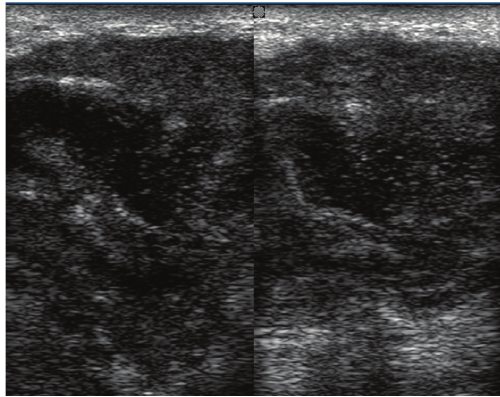
Figure 2: Ultrasonographic findings ill defined hypoecoic lesion.